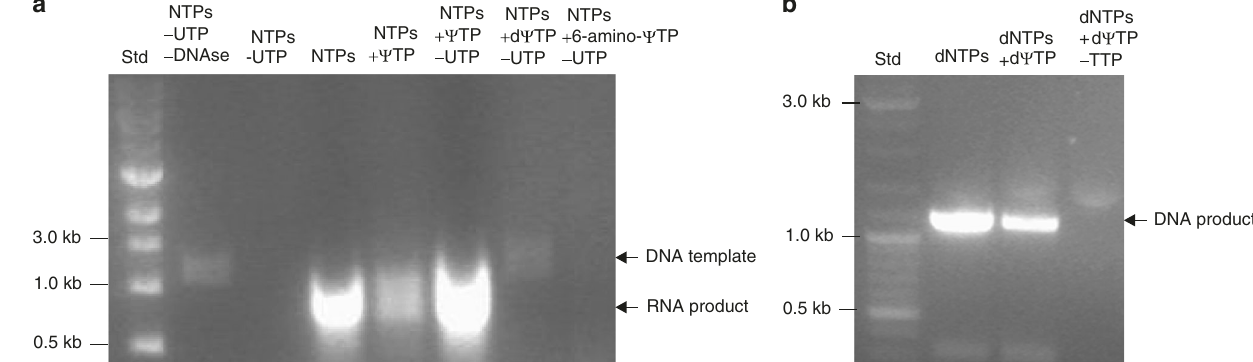
Fig. 6 Polymerase-catalyzed ampli fi cation of RNA and DNA. Panels a and b show RNA and DNA, respectively. RNA was transcribed from YeiN-encoding template DNA ( n = 1). a In vitro translation was performed using standard conditions, 30 U of T7 RNA polymerase, 700 ng template DNA,